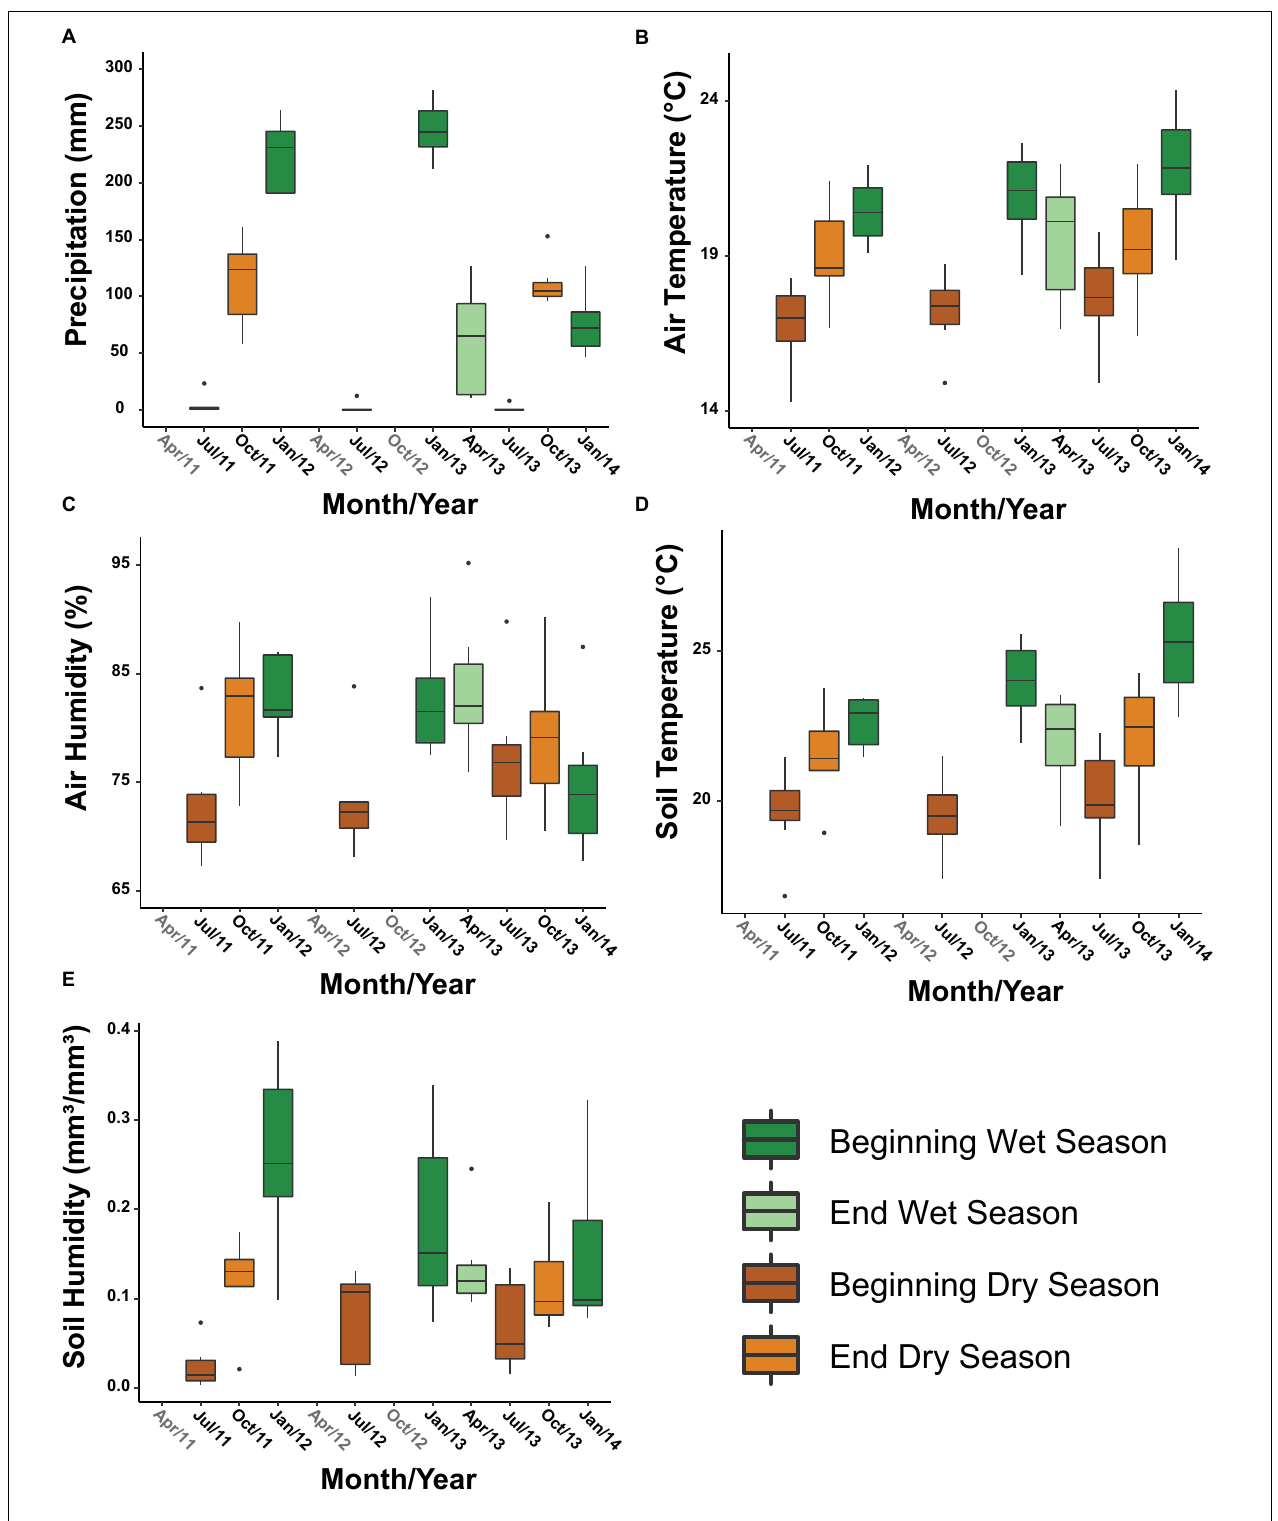
FIGURE 4 | Variation of (A) precipitation, (B) air temperature, (C) air humidity, (D) soil temperature, and (E) soil humidity over 12 periods in the beginning and end of wet and dry seasons. The boxplots represent the variation of the mean values of the seven sampling sites (different elevations) in each month/year. Data sampled using meteorological monitoring towers along an elevational gradient in Serra do Cipó, Minas Gerais State – Brazil.